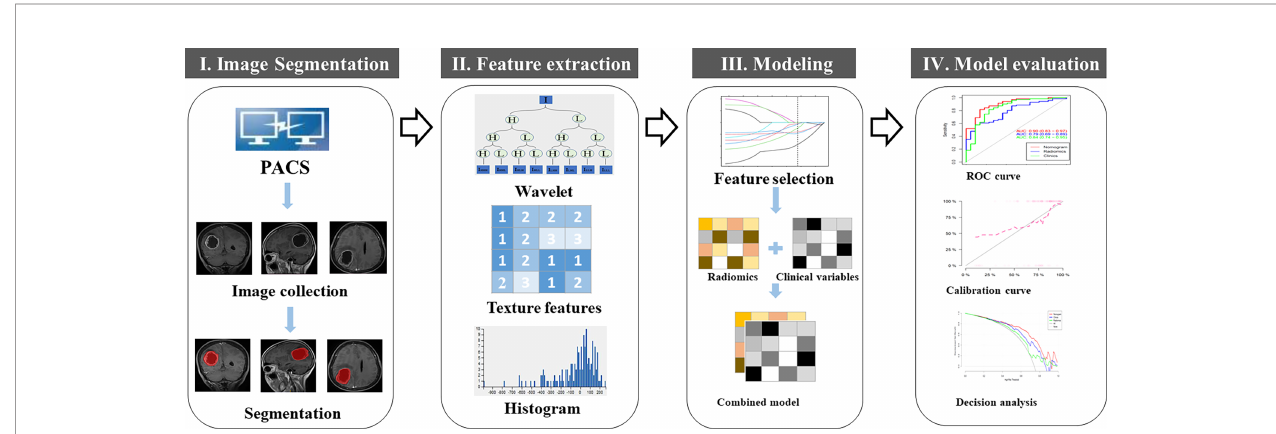
FIGURE 2 | Work fl ow for tumor segmentation, radiomic feature extraction and predictive